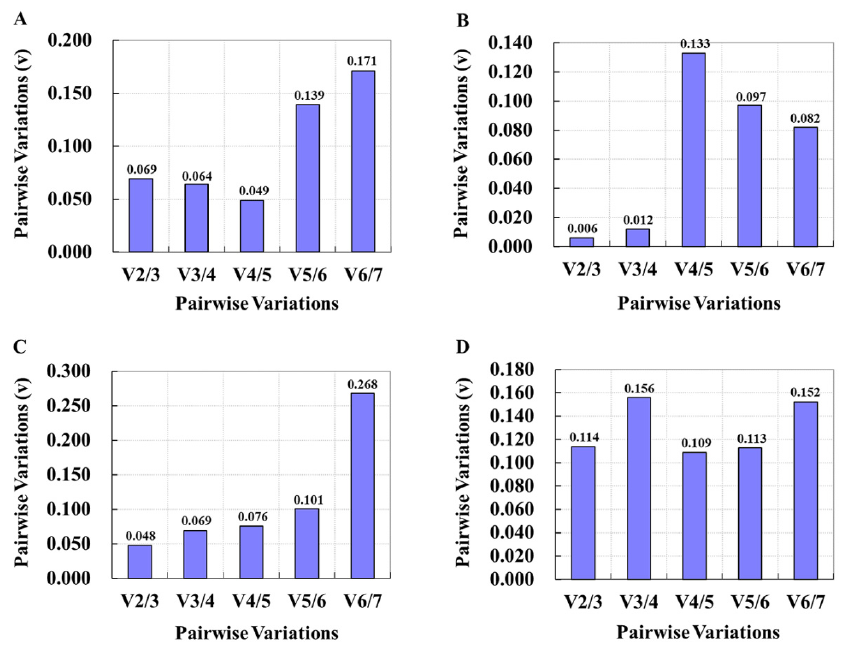
Figure 3. The expression stability of housekeeping gene candidates in GPS cells under stimulation with LPS for 2 ( A ), 4 ( B ), 8 ( C ) and 12 h ( D ) assessed by geNorm. According to the C t values presented by seven housekeeping gene candidate stimulations with LPS or PBS, the average expression stability of housekeeping gene candidates can be evaluated as M by geNorm; not only can the M value not be more than 1.5, but the most reliable housekeeping genes have the most minimal M value as well.